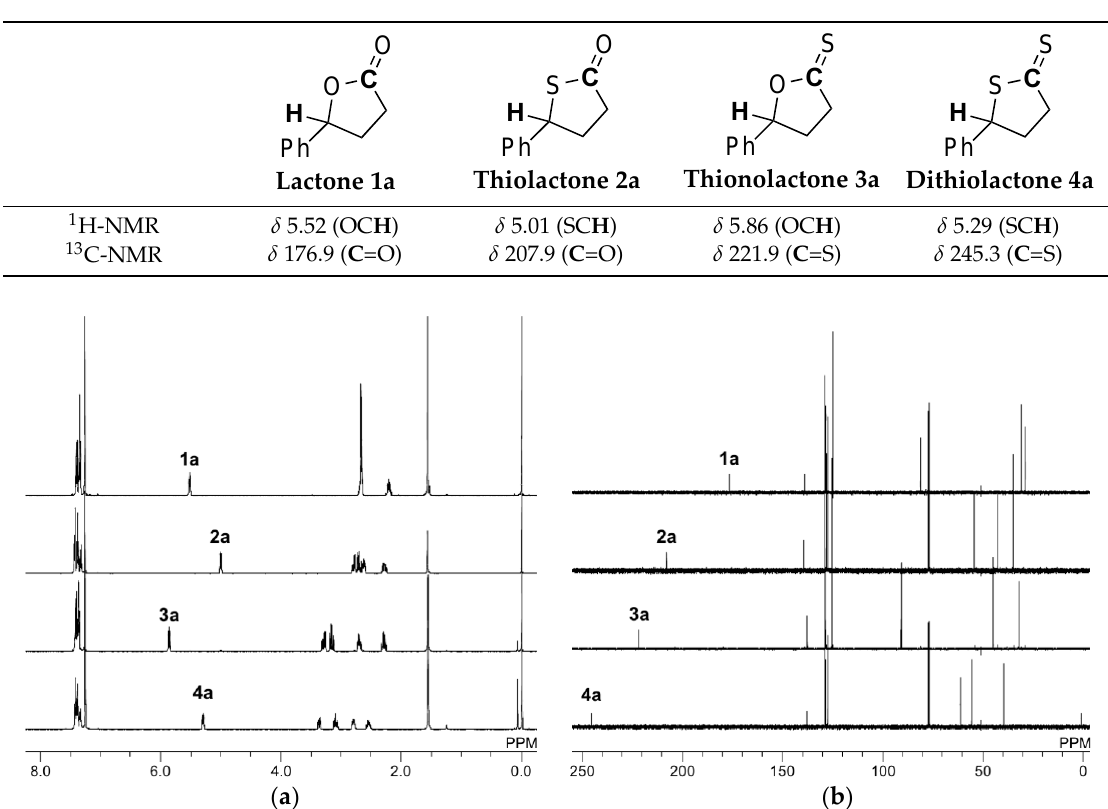
Figure 1. NMR spectra of 1a – 4a : ( a ) 1 H-NMR (500 MHz, CDCl 3 , rt), ( b ) 13 C-NMR (126 MHz, CDCl 3 , rt).